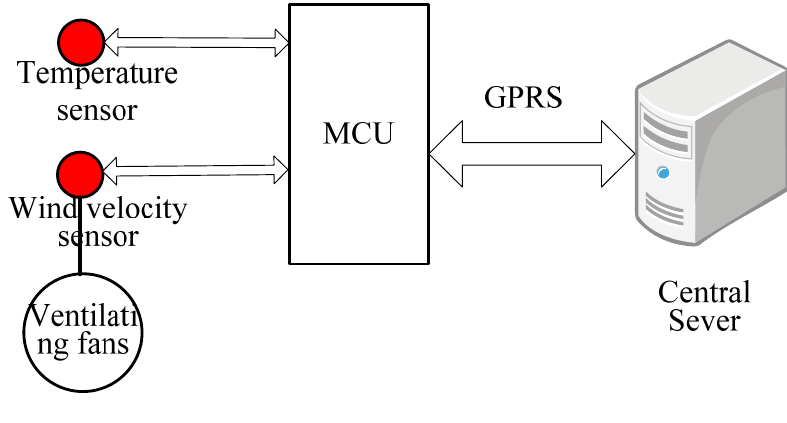
Figure 5. Schematic diagram of the intelligent cooling control